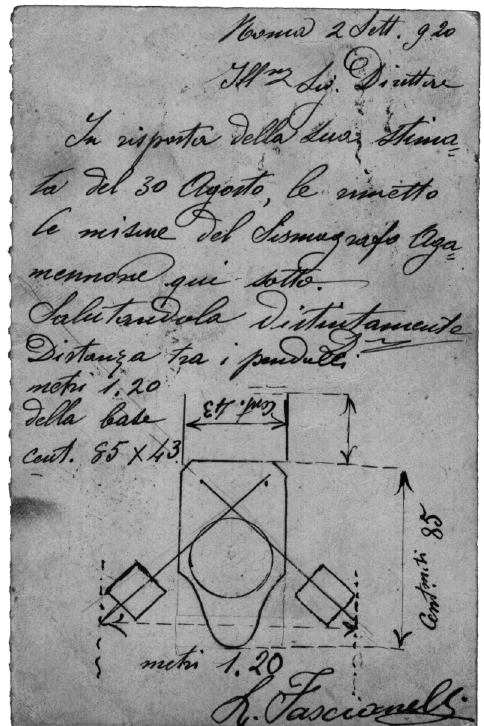
Fig. 5. Card from Luigi Fascianelli, the official in- strument maker of the Central Office of Meteorology and Geodynamics, to Andreoli, the director of the Observatory (September 2nd, 1920) in which a sketch of the Agamennone seismograph with two horizontal components is reported with the related